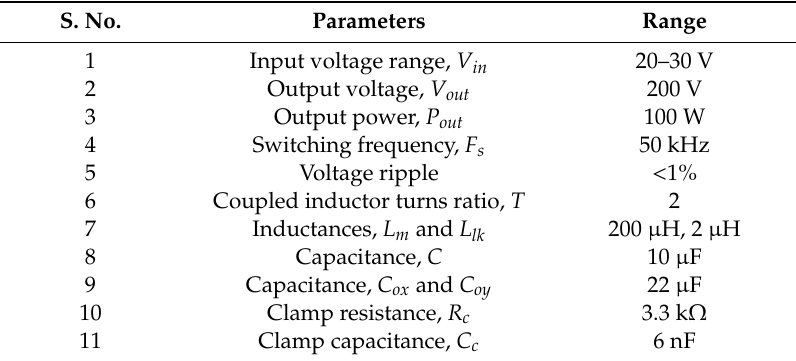
Table 1. Electrical specification of the proposed